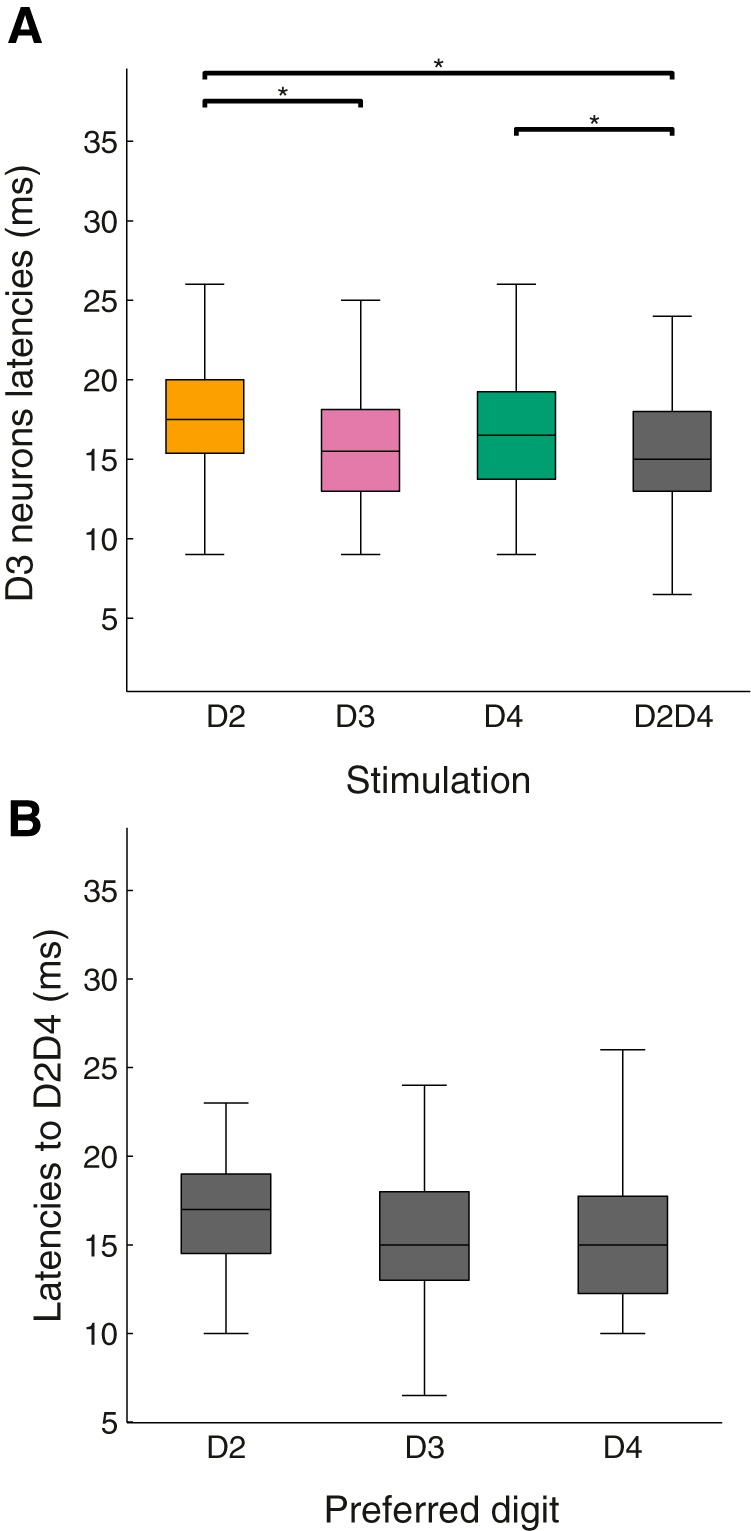
Unit response latency. A, Distribution of the first spike latency after single-digit and D2D4 stimulations for D3-preferring neurons. Note that these neurons responded to D2D4 as fast as to D3. B, Distributions of the first spike latency of the D2-, D3-, and D4-preferring neurons for D2D4 costimulation. There was no significant latency difference among these populations.